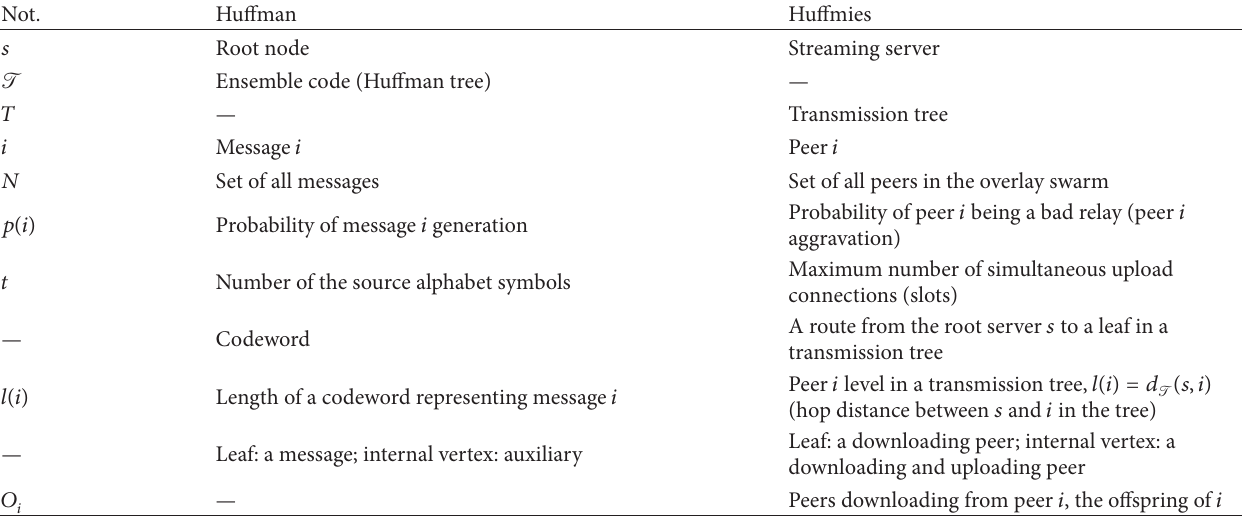
Table 1: The relation of the basic notions for the Huffman coding and the Huffmies concept.